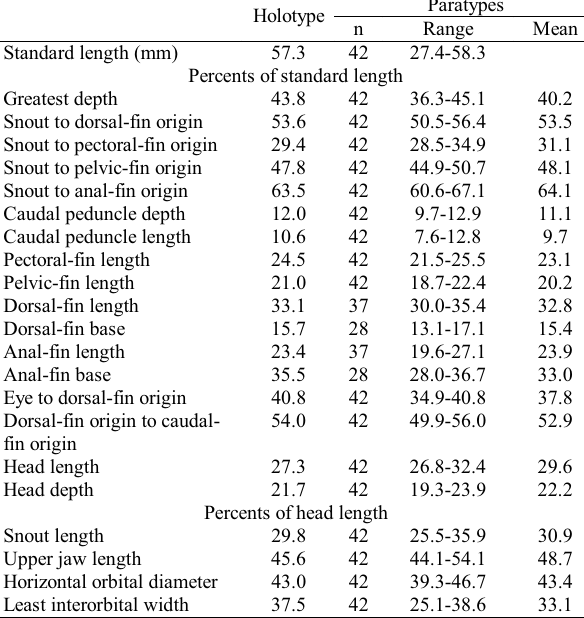
Table 1. Morphometric data for Moenkhausia